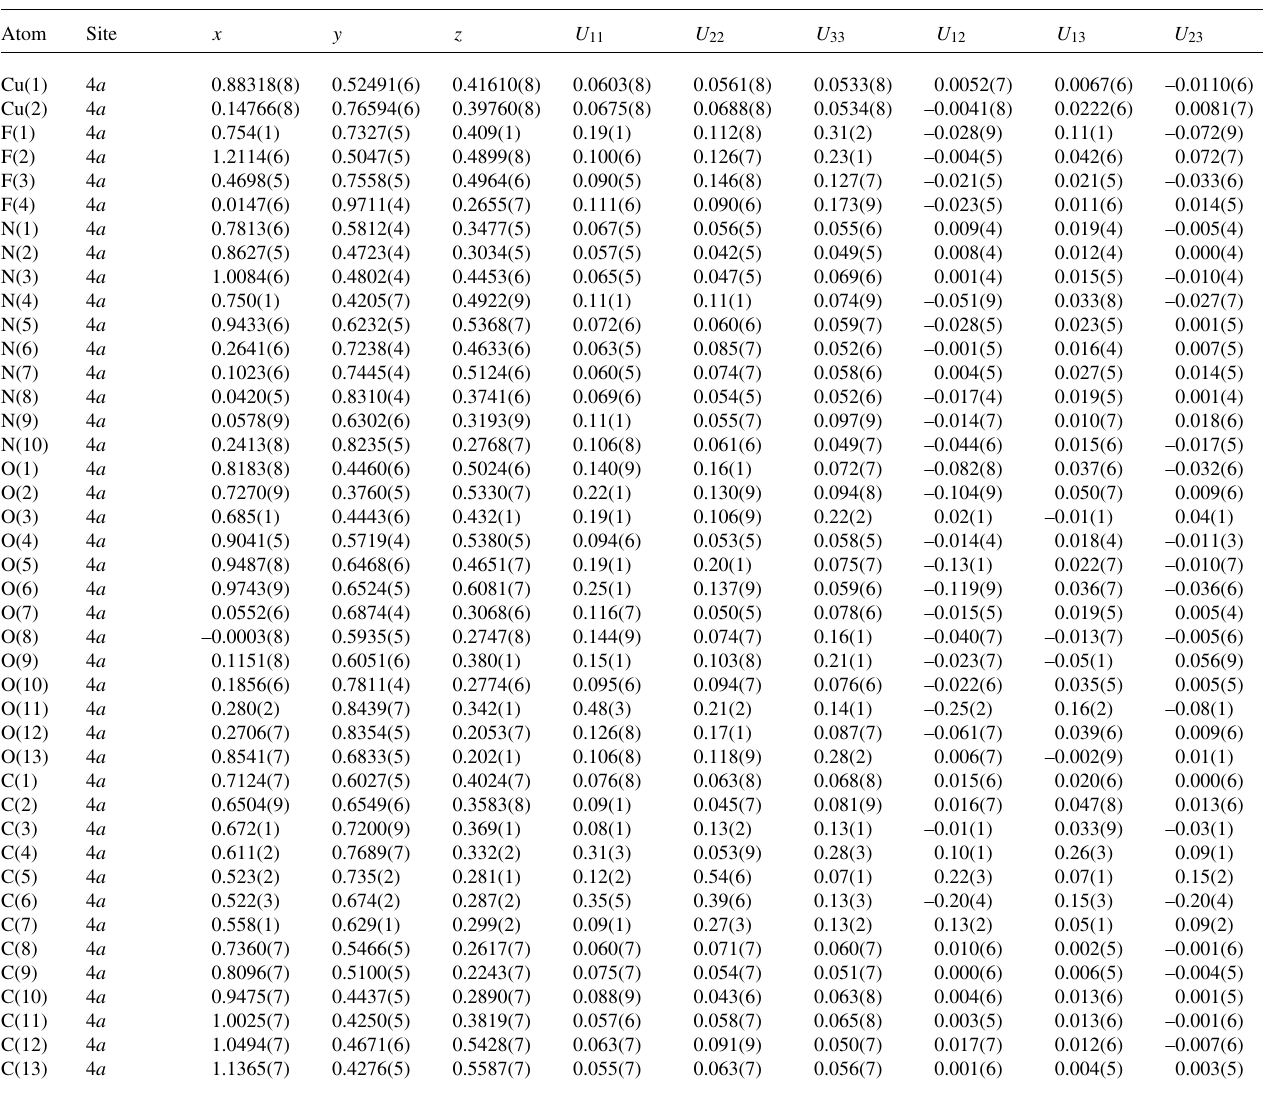
Table 3. Atomic coordinates and displacement parameters (in Å 2 )